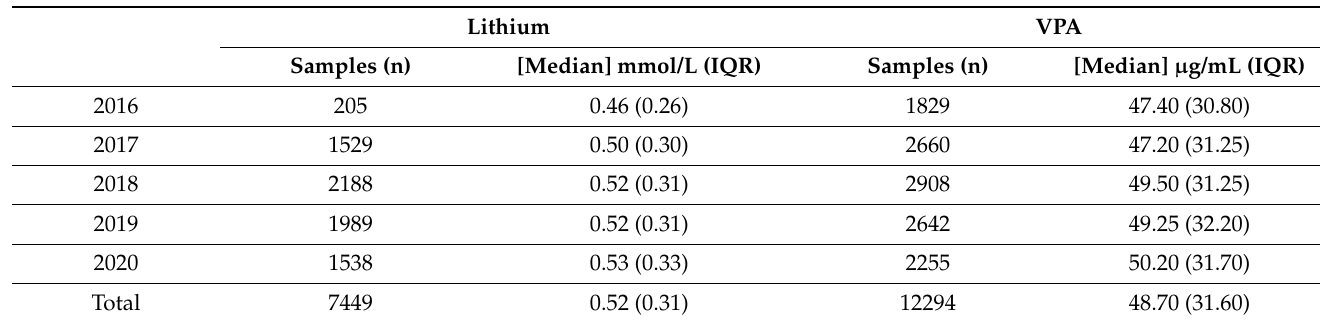
Table 1. The total number of samples collected yearly are reported for both lithium and VPA, together with Cp median values and the relative interquartile range